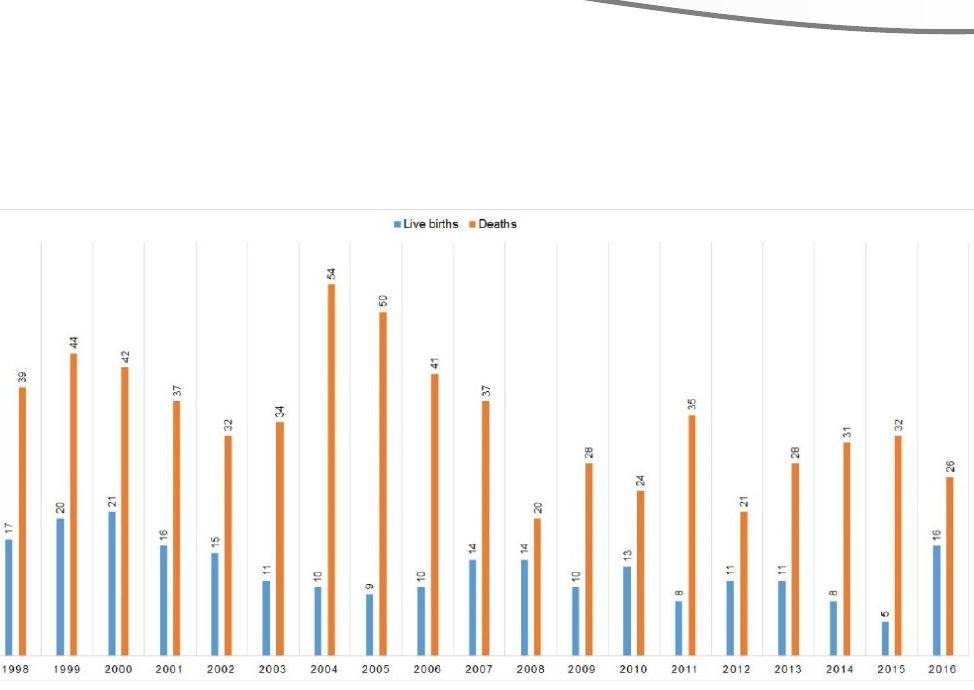
Figure 4: Trend of live births and deaths in Sâncraiu